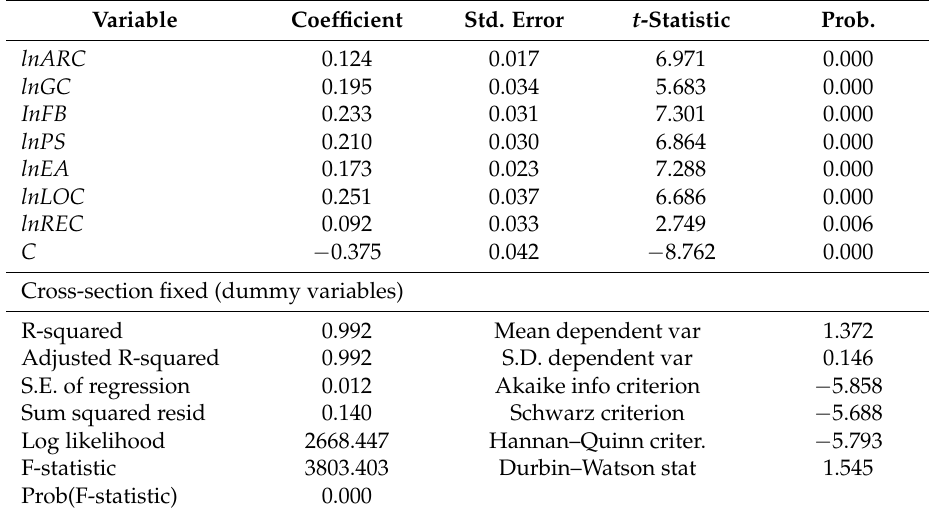
Table 6. Panel fixed coefficient estimation